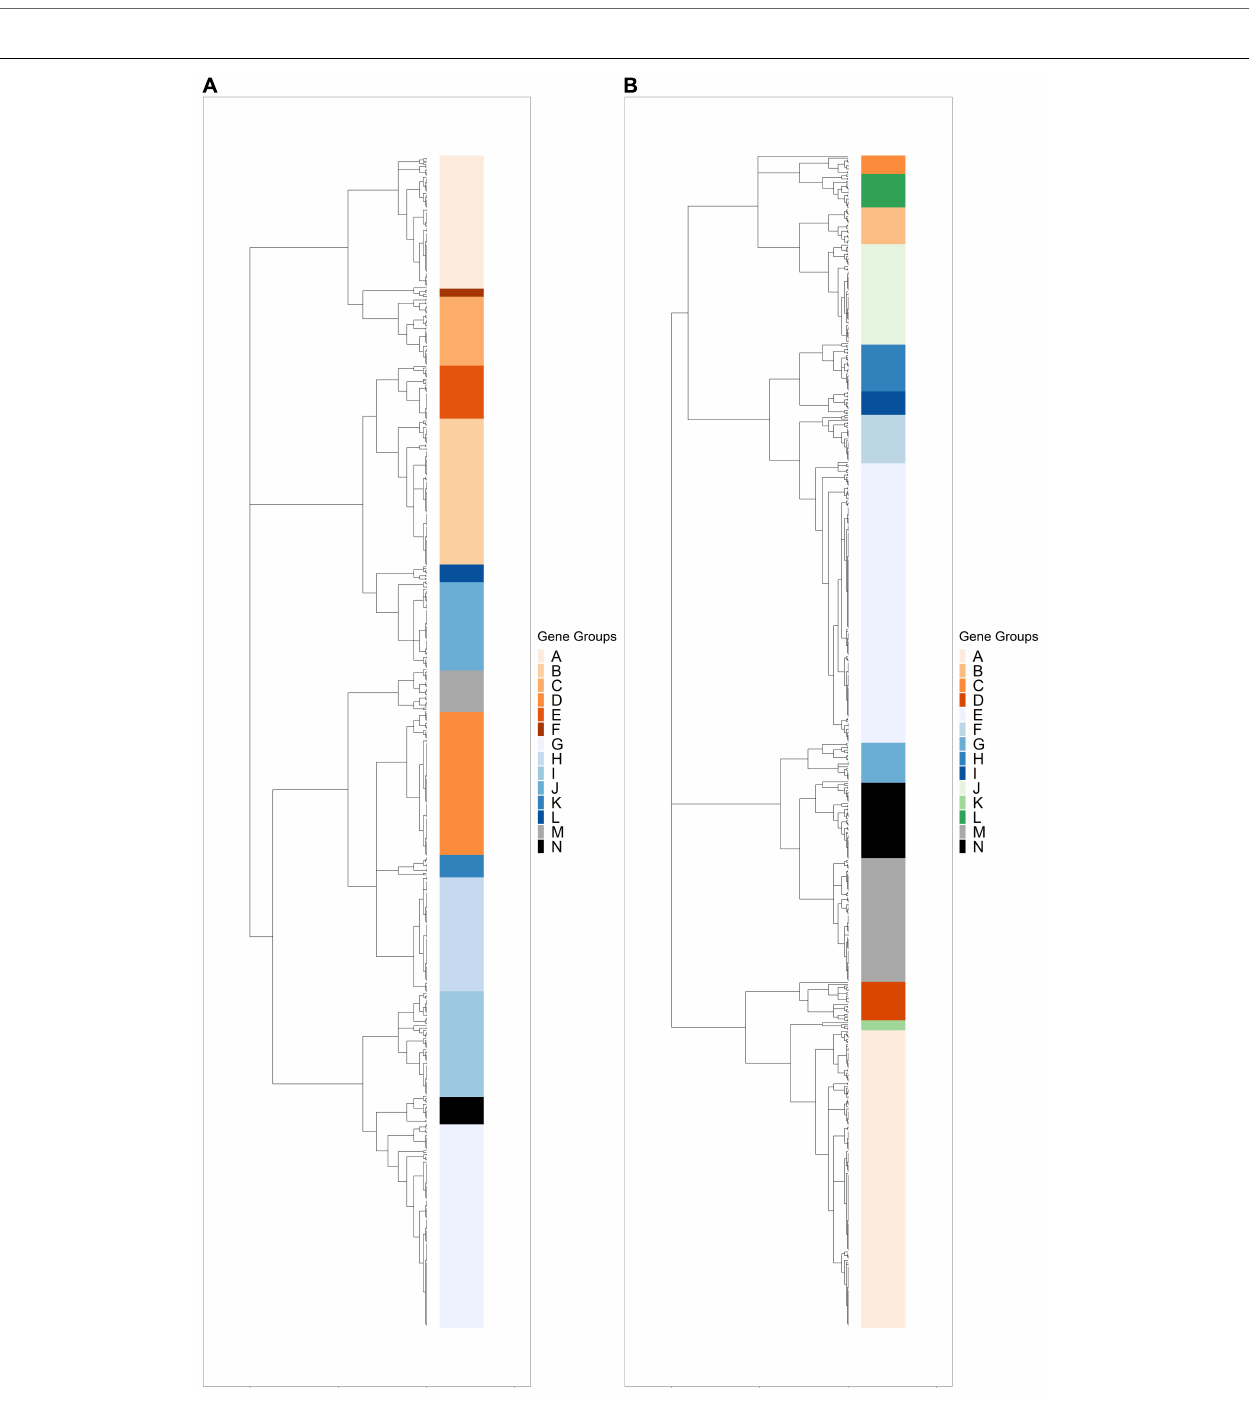
Frontiers in Microbiology |